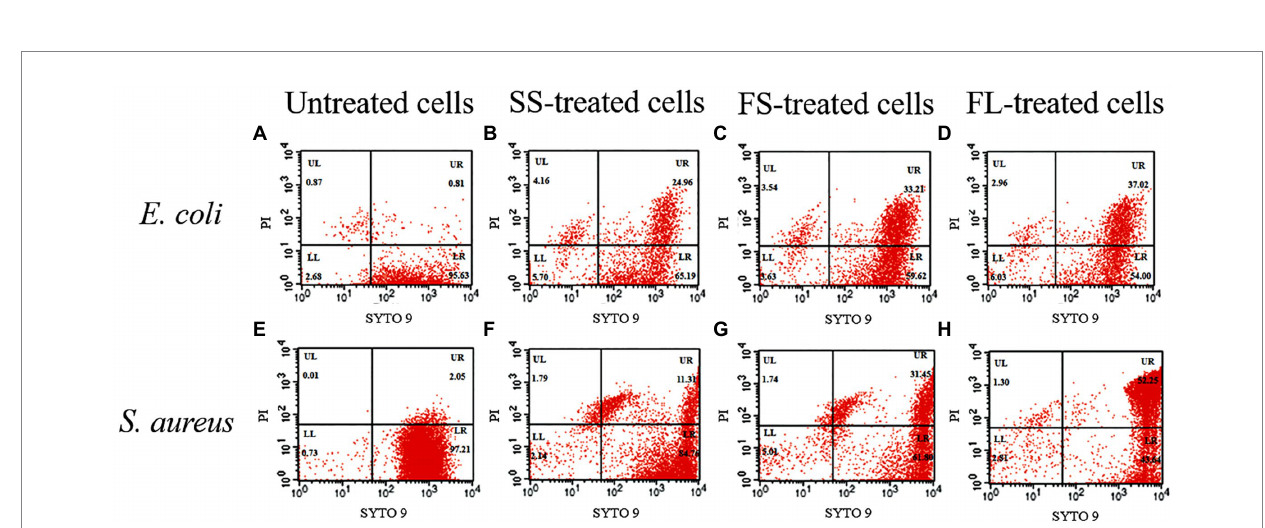
FIGURE 5 Flow cytometry analysis of E. coli and S. aureus treated by high hydrostatic pressure (250 MPa/5 min and 450 MPa/5 min, respectively) and stained with SYTO 9 and PI. (A,E) Control. (B,F) SS treatment. (C,G) FS treatment. (D,H) FL treatment.